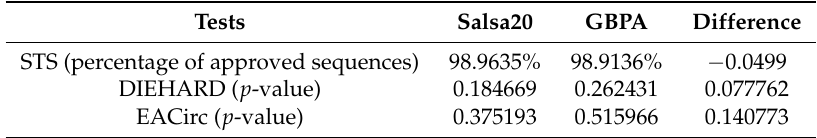
Table 10. Comparison of the results of STS and DIEHARD between Salsa20 and